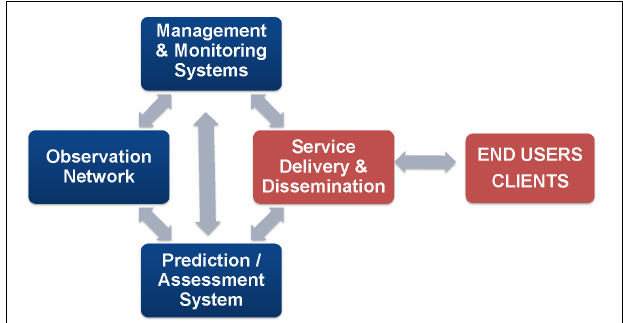
FIGURE 1 | A partition of components of operational oceanography. This figure is slightly modified from Schiller et al. (2018) to better represent the connectivity to Ocean Observations of all components and the flow of information to the end user. Orange boxes are the components related to end use of Ocean Observations and